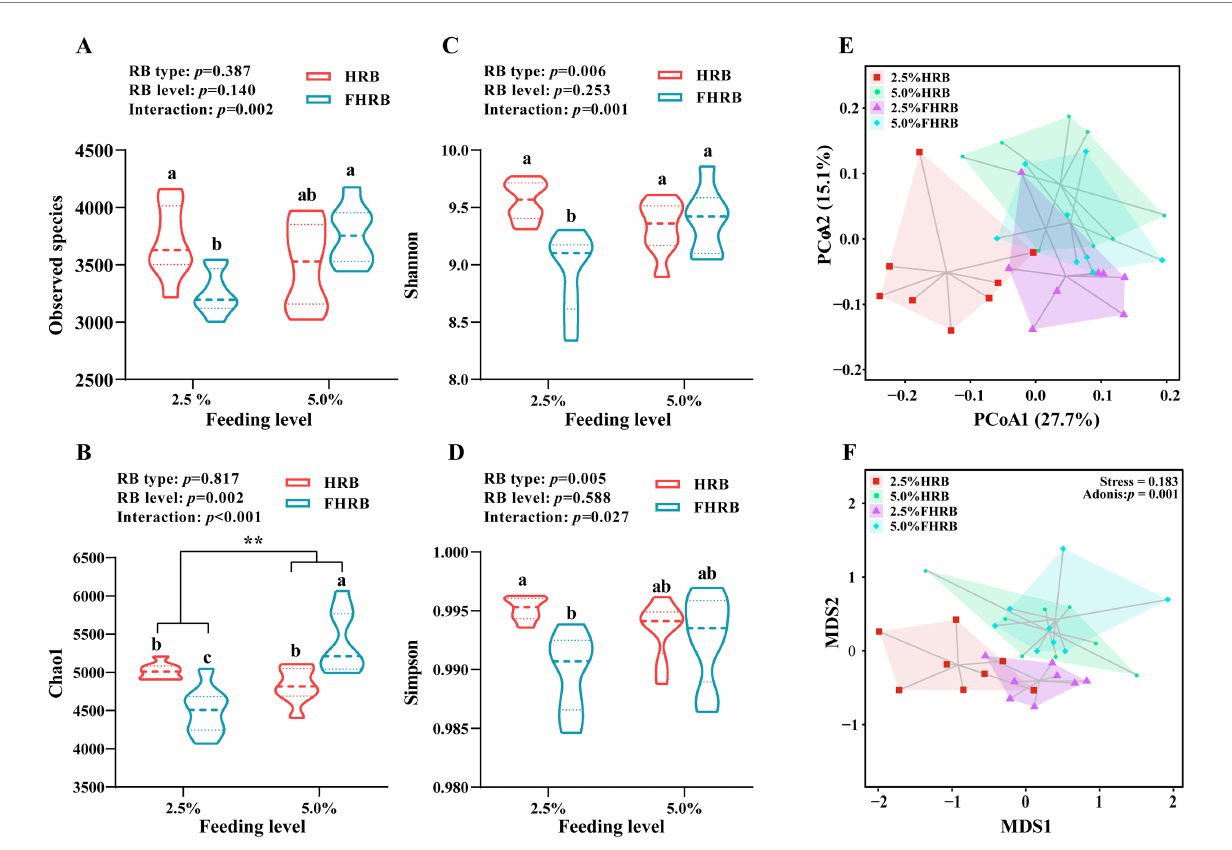
FIGURE 1 Effects of RB type and feeding level on the cecal microbial diversity in laying hens. ( A–D , alpha diversity; E,F , beta diversity). (A) Observed species. (B) Chao1. (C) Shannon. (D) Simpson. (E) Principal coordinate analysis (PCoA). (F) NMDS analysis. All values are expressed as the means with standard ( n = 8). p < 0.05 indicates that the main effect and interaction have significant differences. * and ** indicate significant ( p < 0.05) and highly significant ( p < 0.01) differences at feeding level, respectively. Based on interaction p < 0.05, a–c values with different letters are significantly different at p <